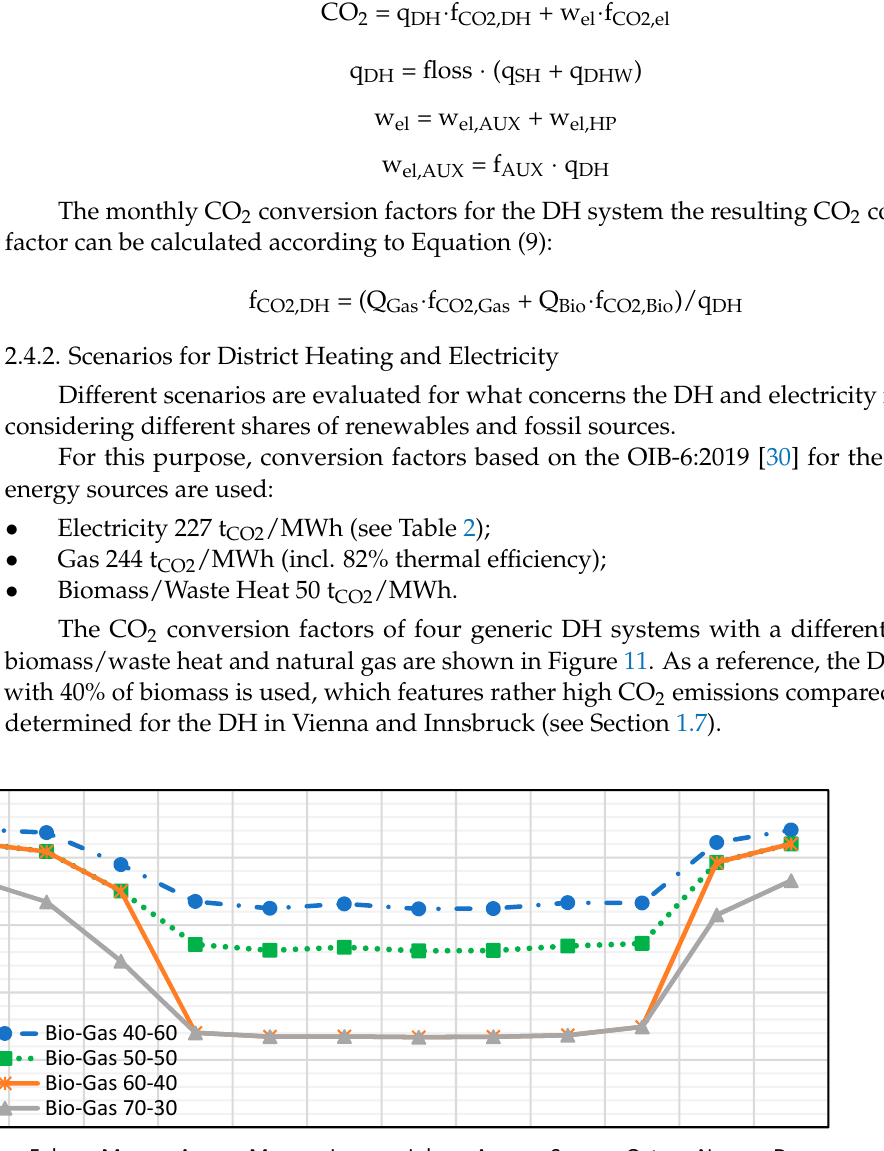
Figure 12. CO 2 conversion factors for electricity according to two scenarios of a generic electricity mix with 10% hydro, 10% wind and 10% PV and 10% hydro, 30% wind and 30% PV, respectively (residual fossil), according to [29]. A constant conversion factor of electricity of f CO2el = 227 g/kWh is used as a reference; additionally, the scenarios shown in Figure 12 are applied to show the influence of the seasonal variation of the electricity mix. 2.4.3. Model for Combined Heat and Power Gas and Biomass base load plants are typically operated as CHP plants. The CHP coefficient (power to heat ratio) is defined as the ratio between electricity generation (W el ) and thermal generation (Q th ):